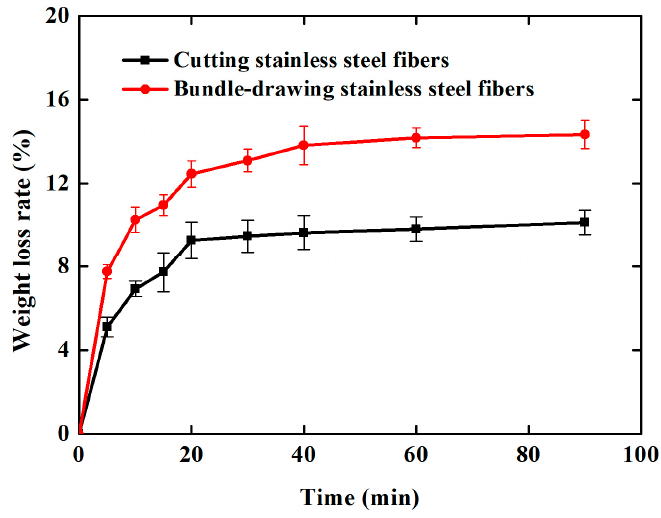
Figure 7. Weight loss rate-time curves of samples during ultrasonic vibration testing.